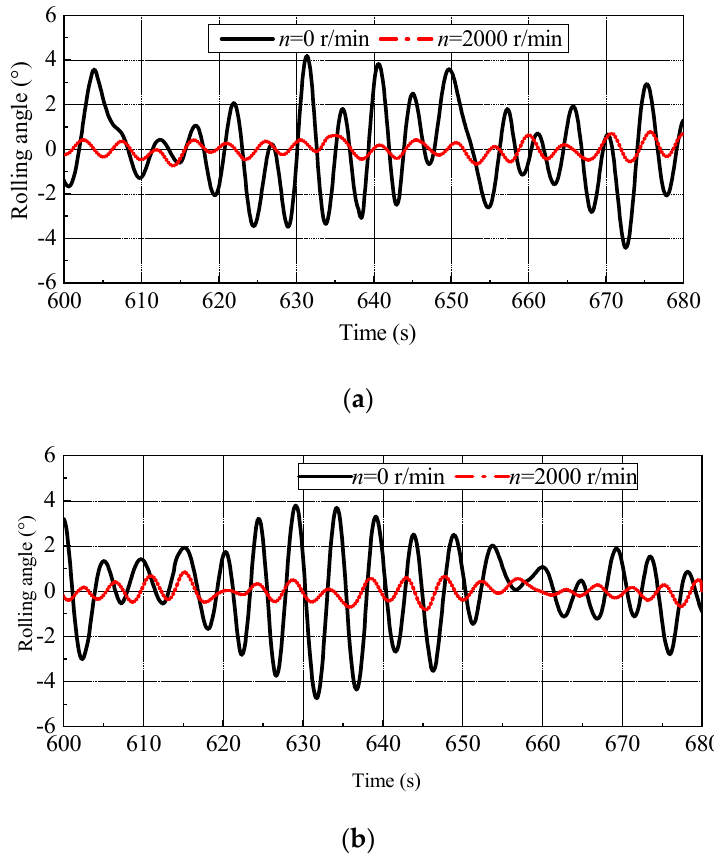
Figure 15. Time-series roll motion for varying wave encounter angles. ( a ) μ = 30°; ( b ) μ = 60°.